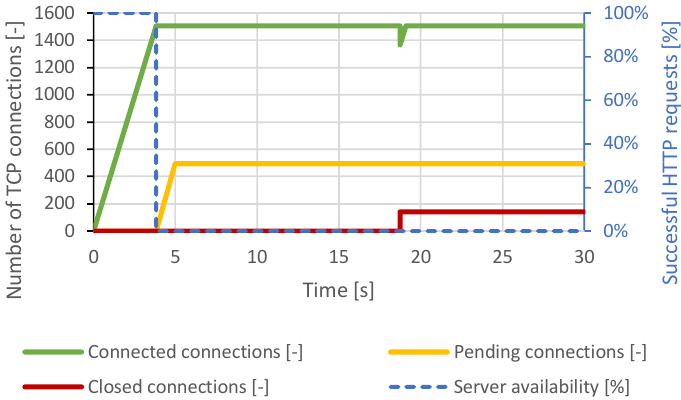
Figure 13. Slowloris attack against lighttpd